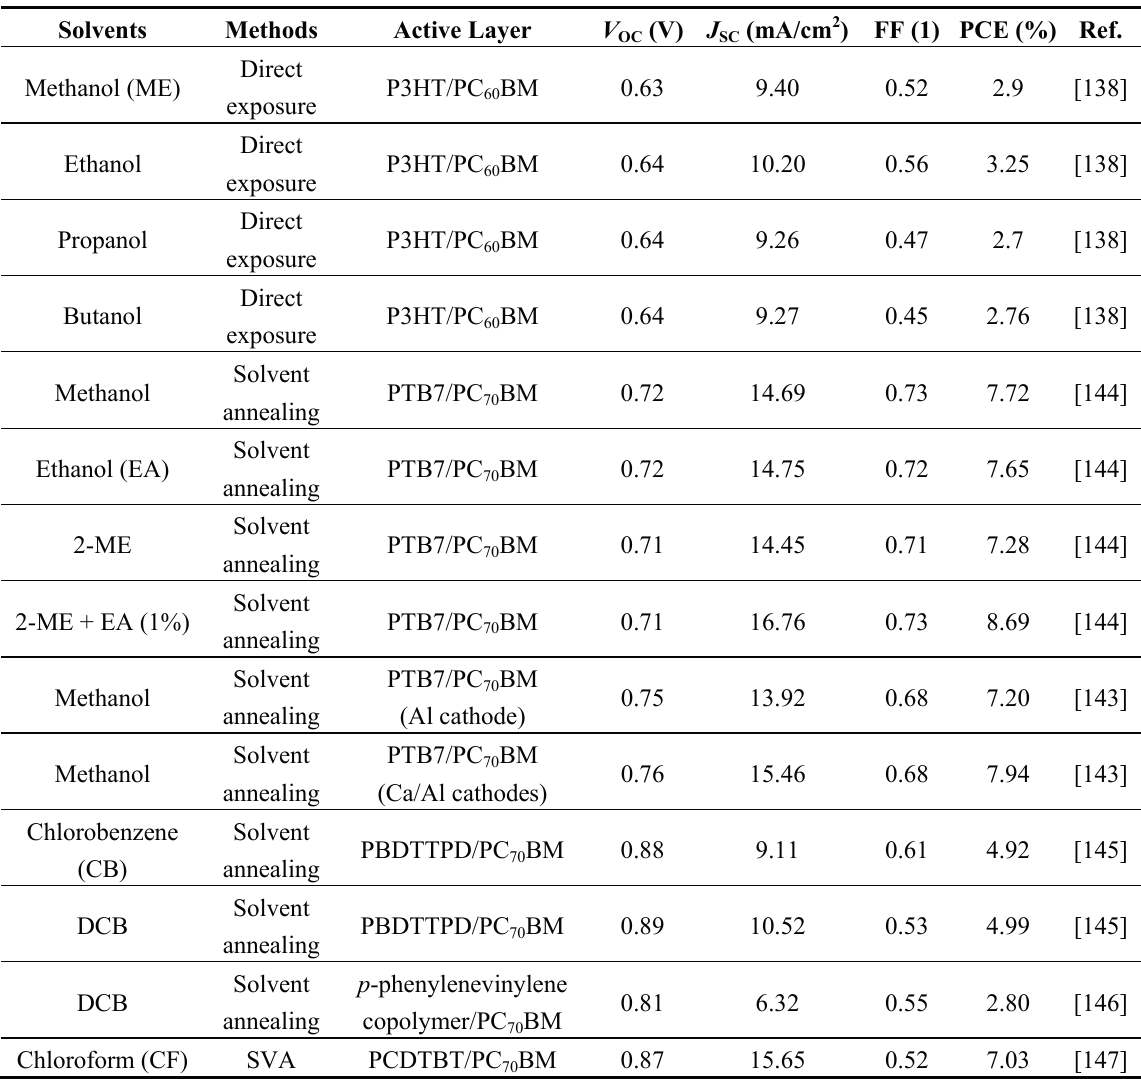
Table 1. Summary of device characteristics of OPVs with different polar solvent treatments. FF, fill factor; PCE, power conversion